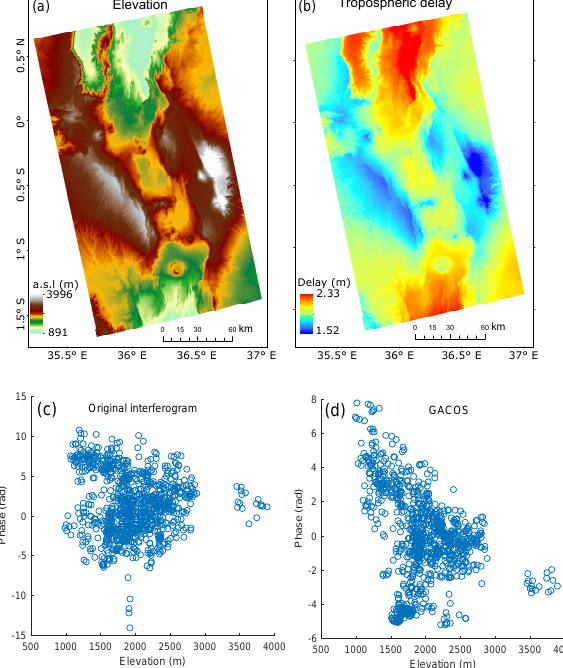
Figure 4. A comparison of correlation between elevation (a) and GACOS differential tropospheric delay and the correlation between elevation and unwrapped phase. (c) shows the correlation between the original interferogram (20180303-20180315) and elevation while (d) is the correlation between corresponding GACOS differential delay and elevation.